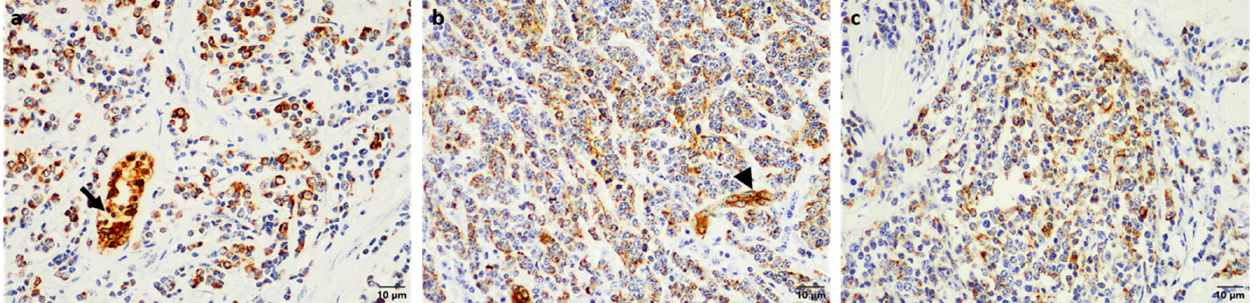
Figure 3. Immunohistochemical staining for cytokeratin in the neoplastic cells. Neoplastic cells in the ( a ) uterus, ( b ) liver, and ( c ) pleura showing strong cytoplasmic cytokeratin-positive labelling by immunohistochemistry (bar = 10 μ m) with the normal uterine glands (arrow) and hepatic bile ducts (arrowhead) serving as internal controls.